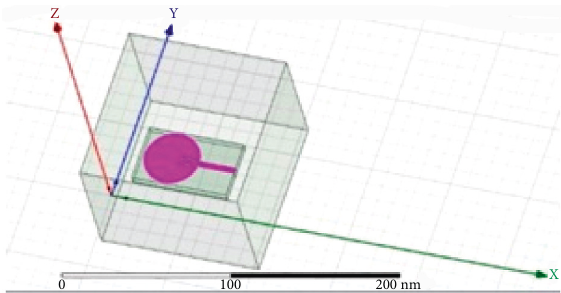
Figure 3: Design of circular patch antenna using graphene material.